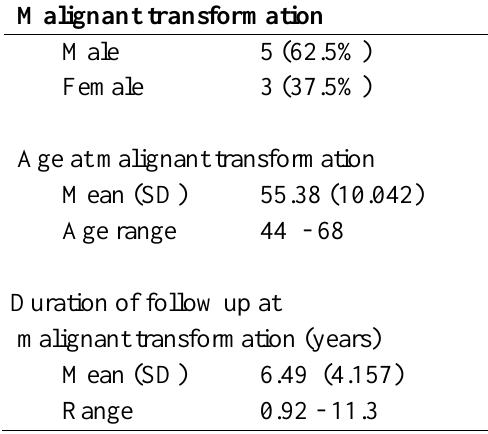
Table 2: Characteristics of the patients with malignant transformation (n=8) Malignant transformation